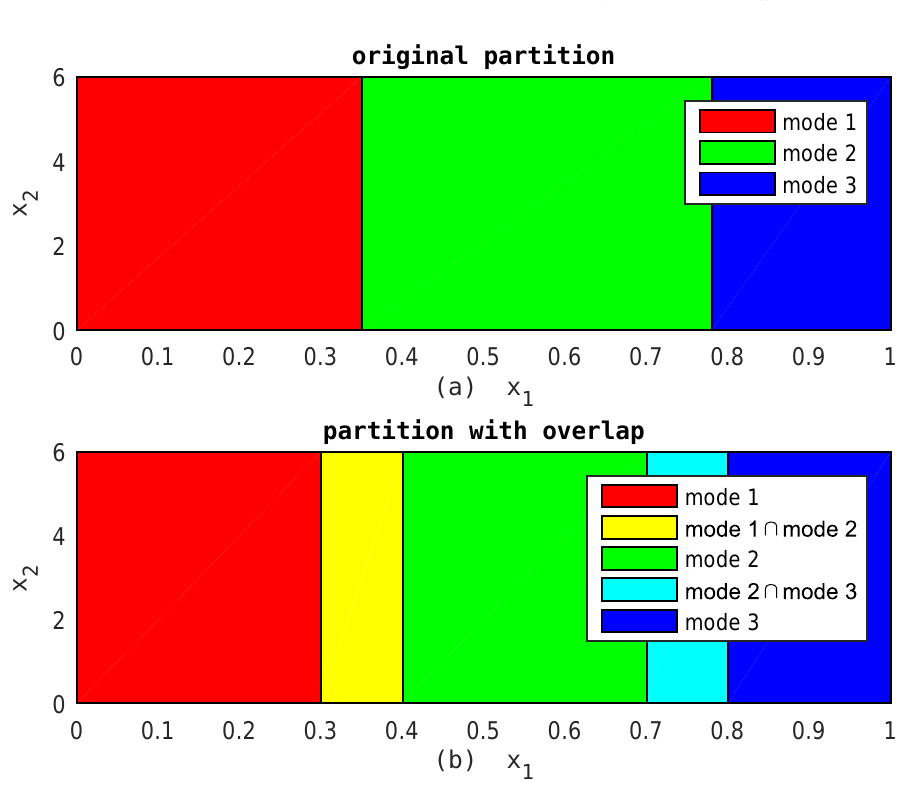
Figure 5. Operating space partition without overlapping regions and operating space partition with overlapping